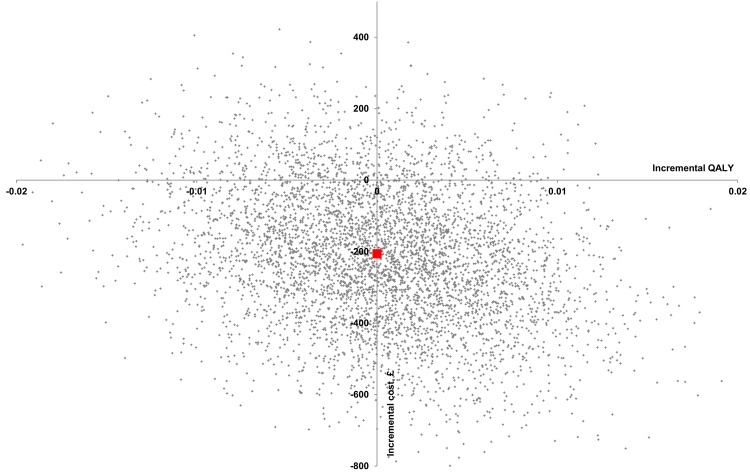
Cost-effectiveness plane–pairwise bootstrapping (adjusted analysis, complete case analysis).Red square represents point estimate 0.000 QALY and -£206.